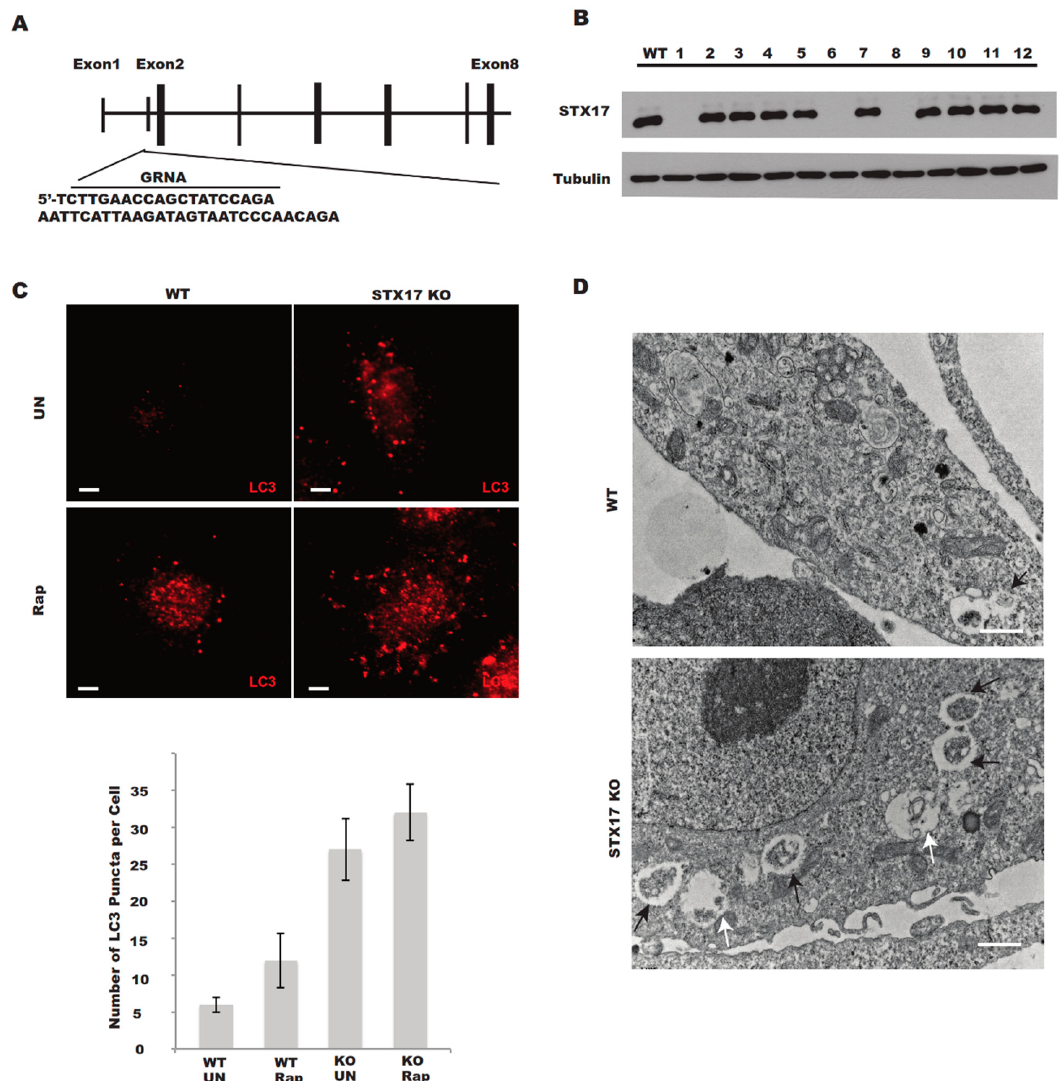
Figure 1. Generation of Syntaxin 17 knockout (STX17 KO) U 2 OS cells. ( A ) Knockout strategy for STX17 by the clustered regularly interspaced short palindromic repeats (CRISPR) / CRISPR-associated protein 9 (Cas9) system. The sequence within exon 1 targeted by single guide RNA is underlined. ( B ) Immunoblotting analysis of wild-type (WT) U 2 OS and 12 puromycin-resistant clones for STX17 knockout. ( C ) Upper panel—Immunostaining of endogenous LC3 in WT and STX17 KO U 2 OS cells. UN, untreated. Rap, rapamycin. Lower panel—Quantification analysis of the upper panel. Scale bar: 5 µ m. ( D ) Electron microscopy analysis of WT and STX17 KO U 2 OS cells. Black arrows indicate autophagosomes. White arrows indicate autolysosomes. Scale bar: 2 µ